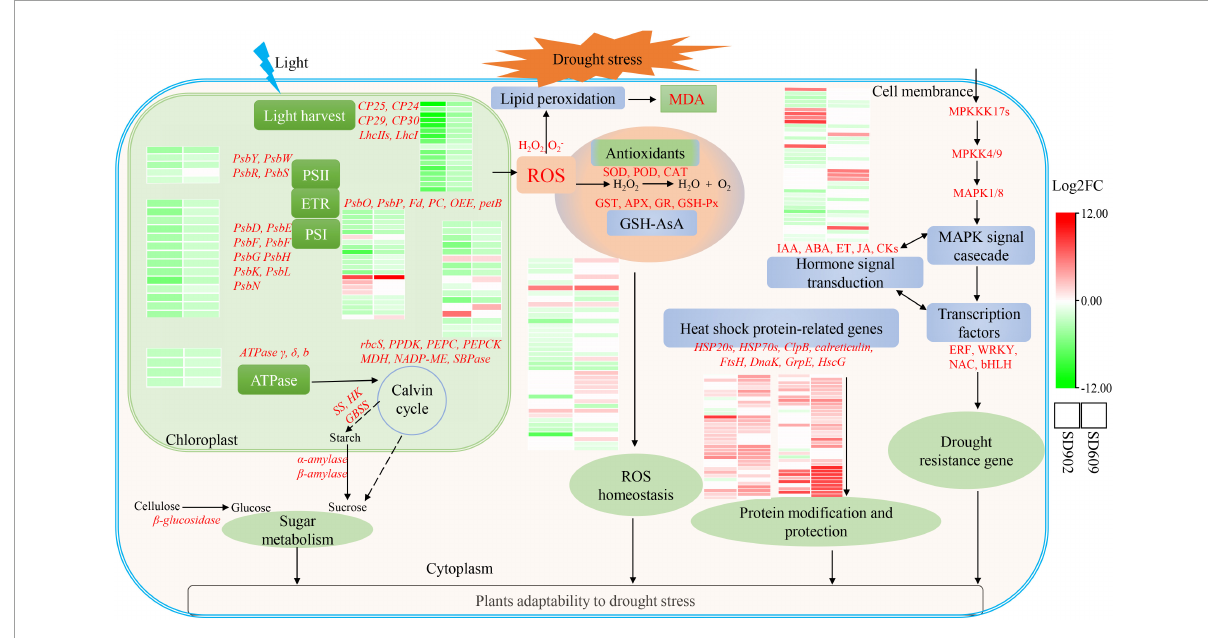
FIGURE6 Working model for the regulatory mechanism of drought tolerance between the two maize genotypes under drought stress conditions. Heatmaps are summarized by log2 (FC) of mRNA levels. Red words represent vital DEGs identified in two maize